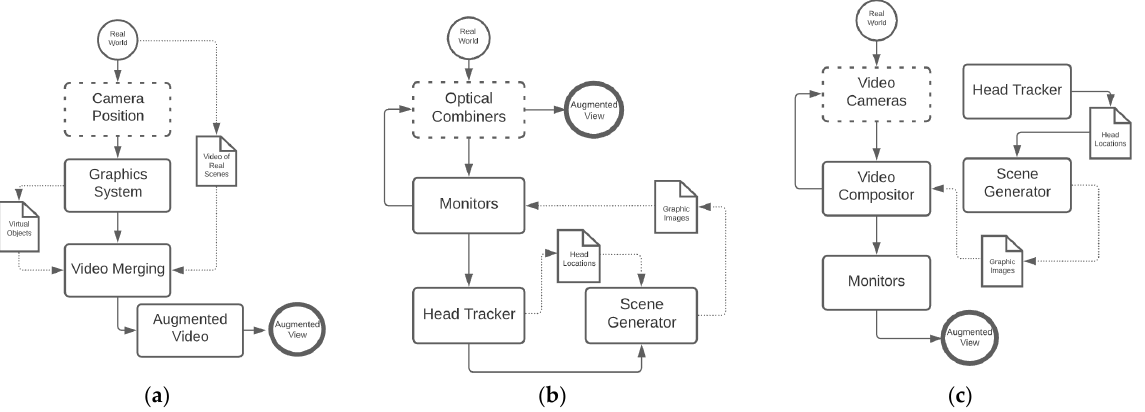
Figure 2. ( a ) Monitor-based AR, ( b ) Optical see-through, ( c ) Video see-through. Emerging immersive approaches, such as the Aryzon headset [4] extend these models further by adopting a mirror-based approach for the optical merging, as displayed in Figure 3. This takes the output from monoscopic to stereoscopic. Where an affinity with the real world environment is created, meaning the user is able to view as a volumetric output without looking directly at the device monitor, transforming the approach from video see-through to optical (however, given its infancy, at the time of writing this article, the related work search found that this technology is yet to be employed in an agricultural setting).